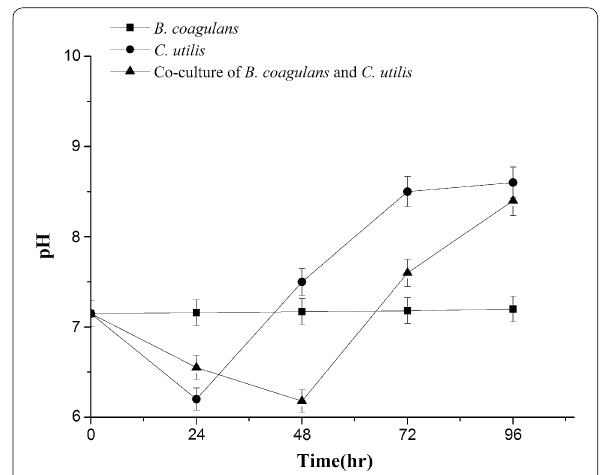
Fig. 7 Changes of pH in the culture solution of B. coagulans and C. utilis using LFW as